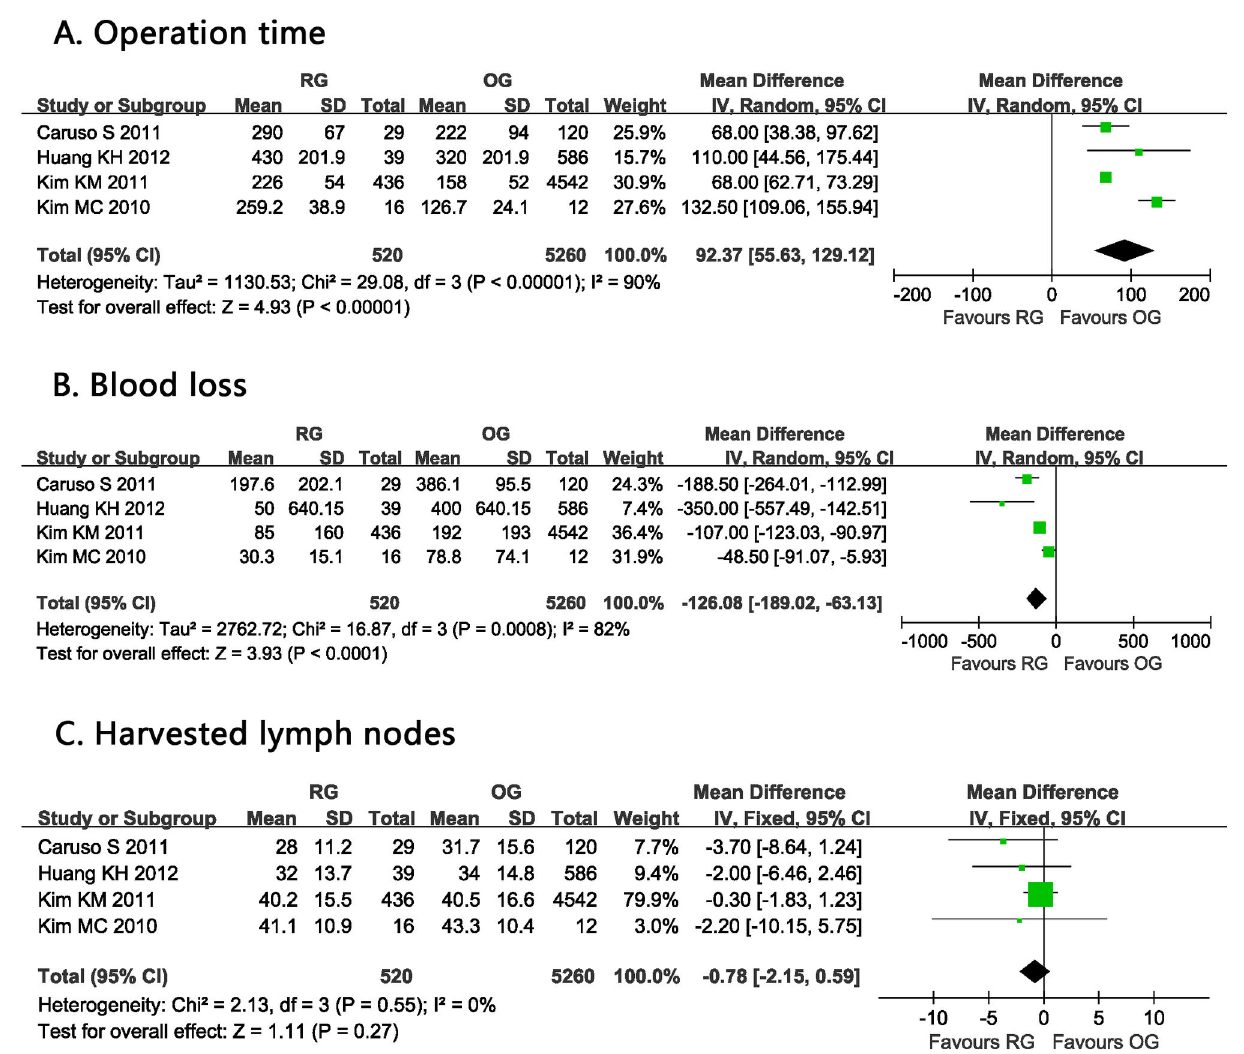
Figure 2. Forest plot showing a meta-analysis for robotic gastrectomy versus open gastrectomy on A. Operation time; B. Blood loss; C. Harvested lymph